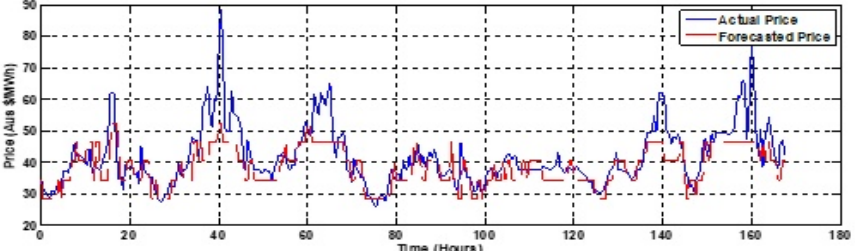
Figure 12. December 8–14, 2015 forecasting with the minimum number of features selected in summer season (MAPE = 11.69).